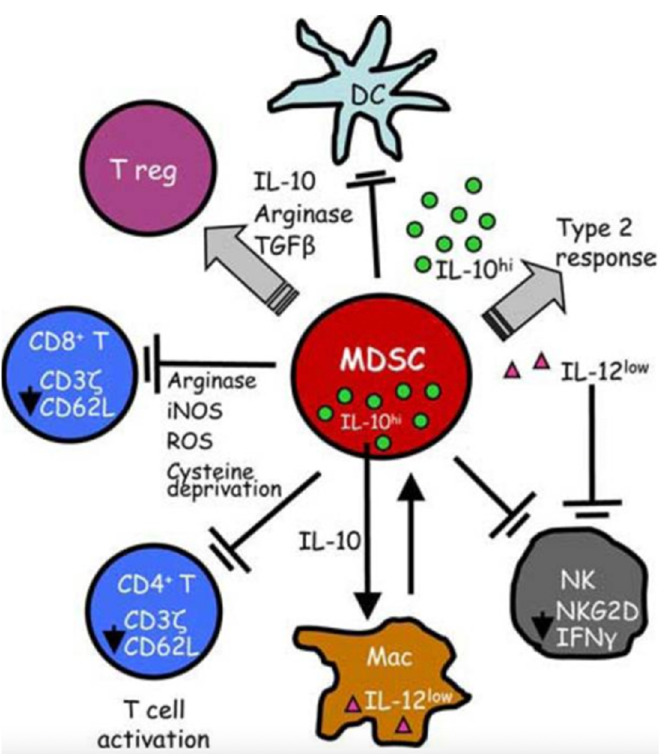
Figure 1. T lymphocyte alteration in sepsis.